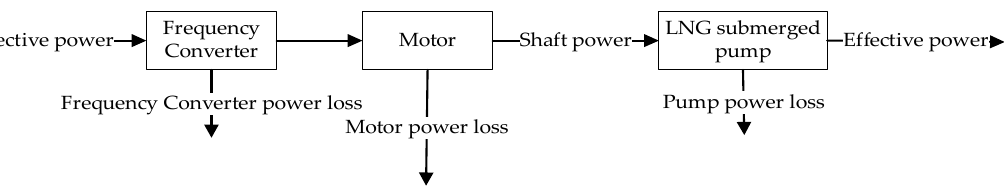
Figure 1. Power loss diagram of general LNG submerged pump.